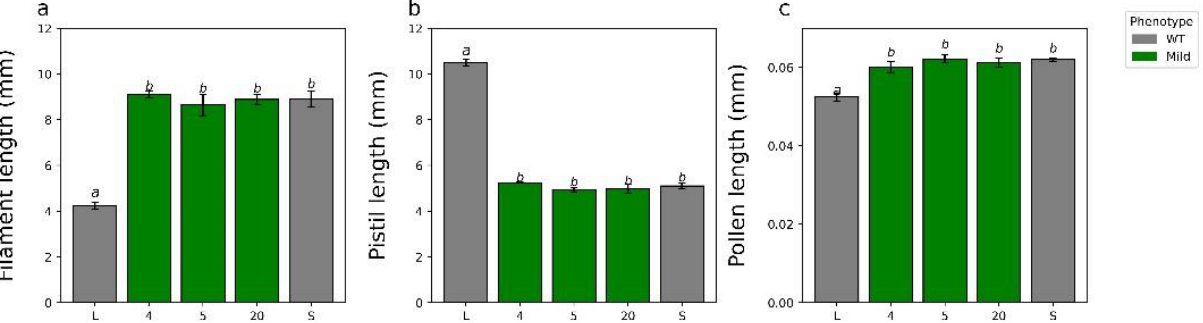
Figure 7. Quantification of the relevant floral characteristics of the T1 lines. ( a ), filament length; ( b ), pistil length; ( c ), pollen length. For all analyses, means sharing the same letter are not significantly different from each other following a single factor ANOVA and Tukey’s test. Error bars represent the standard error. Length of the pistils of three flowers ( a ) F 4,10 = 314.5, p < 0.0001, N = 9 pistils, 3/flower; length of the filaments of three flowers ( b ) F 4,10 = 48.8.5, p < 0.0001, N = 15 filaments, 5/flower; and mean length of pollen grains from three flowers ( c ) F 4,10 = 14.6, p < 0.0004, N = 300 pollen grains, 100/flower.